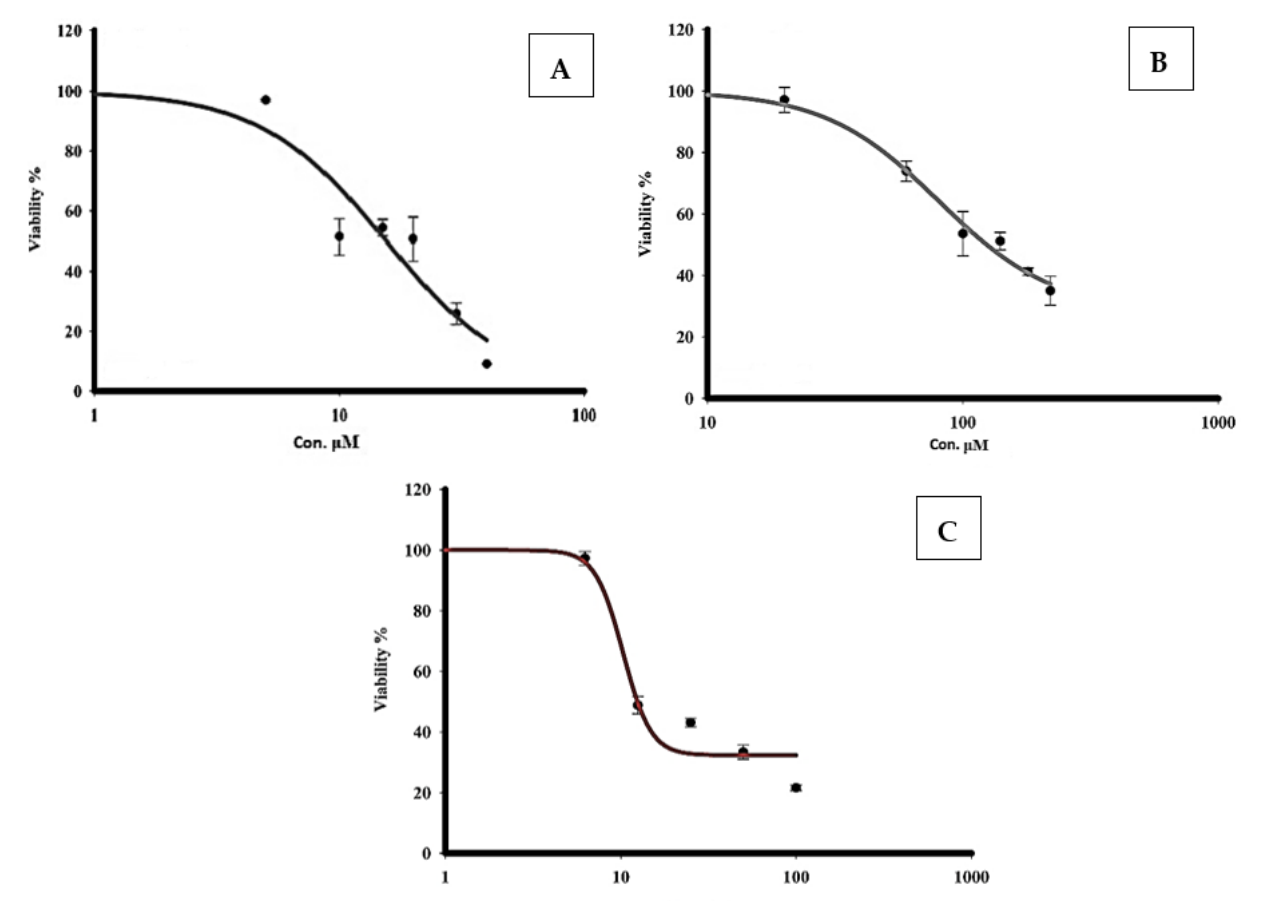
Figure 9. Effect of treatment with sorafenib ( A ), quercetin ( B ) and sorafenib/quercetin ( C ) on HepG2 cell viability. IC50 value corresponds to the concentration that reduces cell viability to 50%. Data are expressed as mean ± SEM for three replicates ( n = 3).